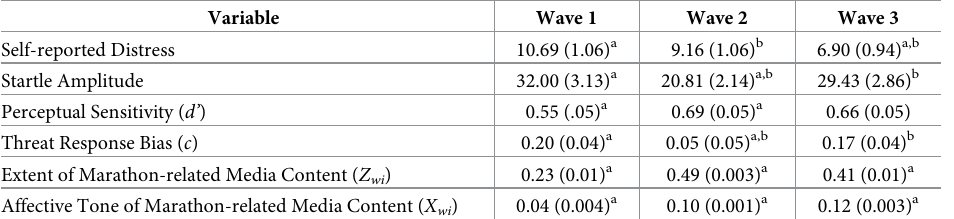
Table 1. Estimated Means and Standard Errors by Wave